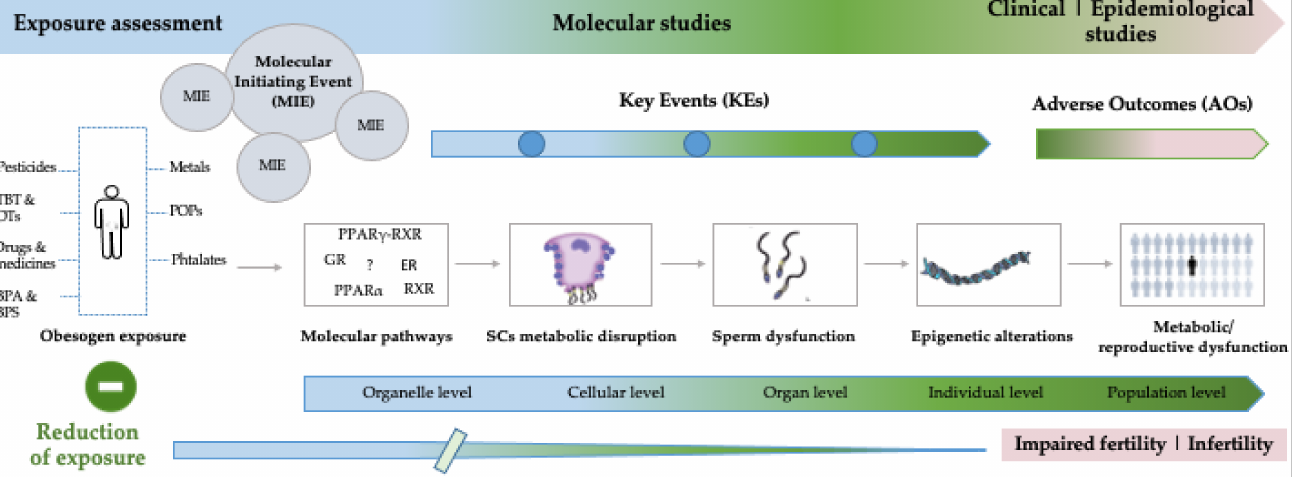
Figure 1. Overview of the impact of obesogens on reproductive function with the indication of the potential sources of obesogens known to affect the male reproductive system, alongside with the depiction of the Adverse Outcome Pathways. BPA: bisphenol-A; BPS: bisphenol-S: ER: estrogen receptor; GR: glucocorticoid receptor; OTs: organotin compounds; POPs: persistent organic pollutants; PPAR α : peroxisome proliferator-activated receptor alpha; PPAR γ : peroxisome proliferator-activated receptor gamma; RXR: 9-cis retinoic acid receptor; SCs: Sertoli cells; TBT: